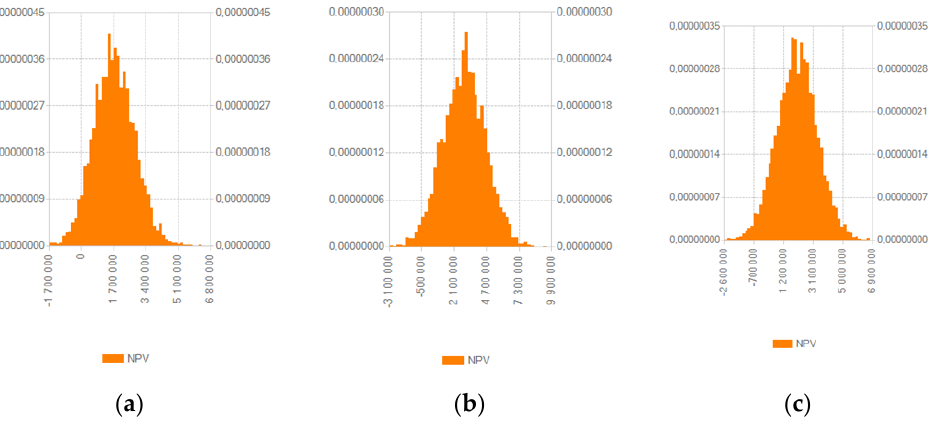
Figure 2. Monte Carlo simulation result NPV values in a histogram. ( a ) “A lternative A ”; ( b ) “A lter- native B ”; ( c ) “A lternative C ” .